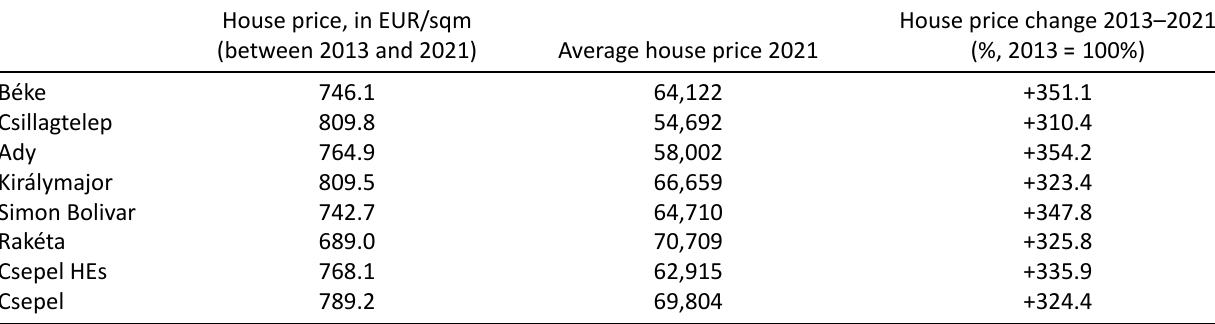
Table 4. House prices of HEs (in